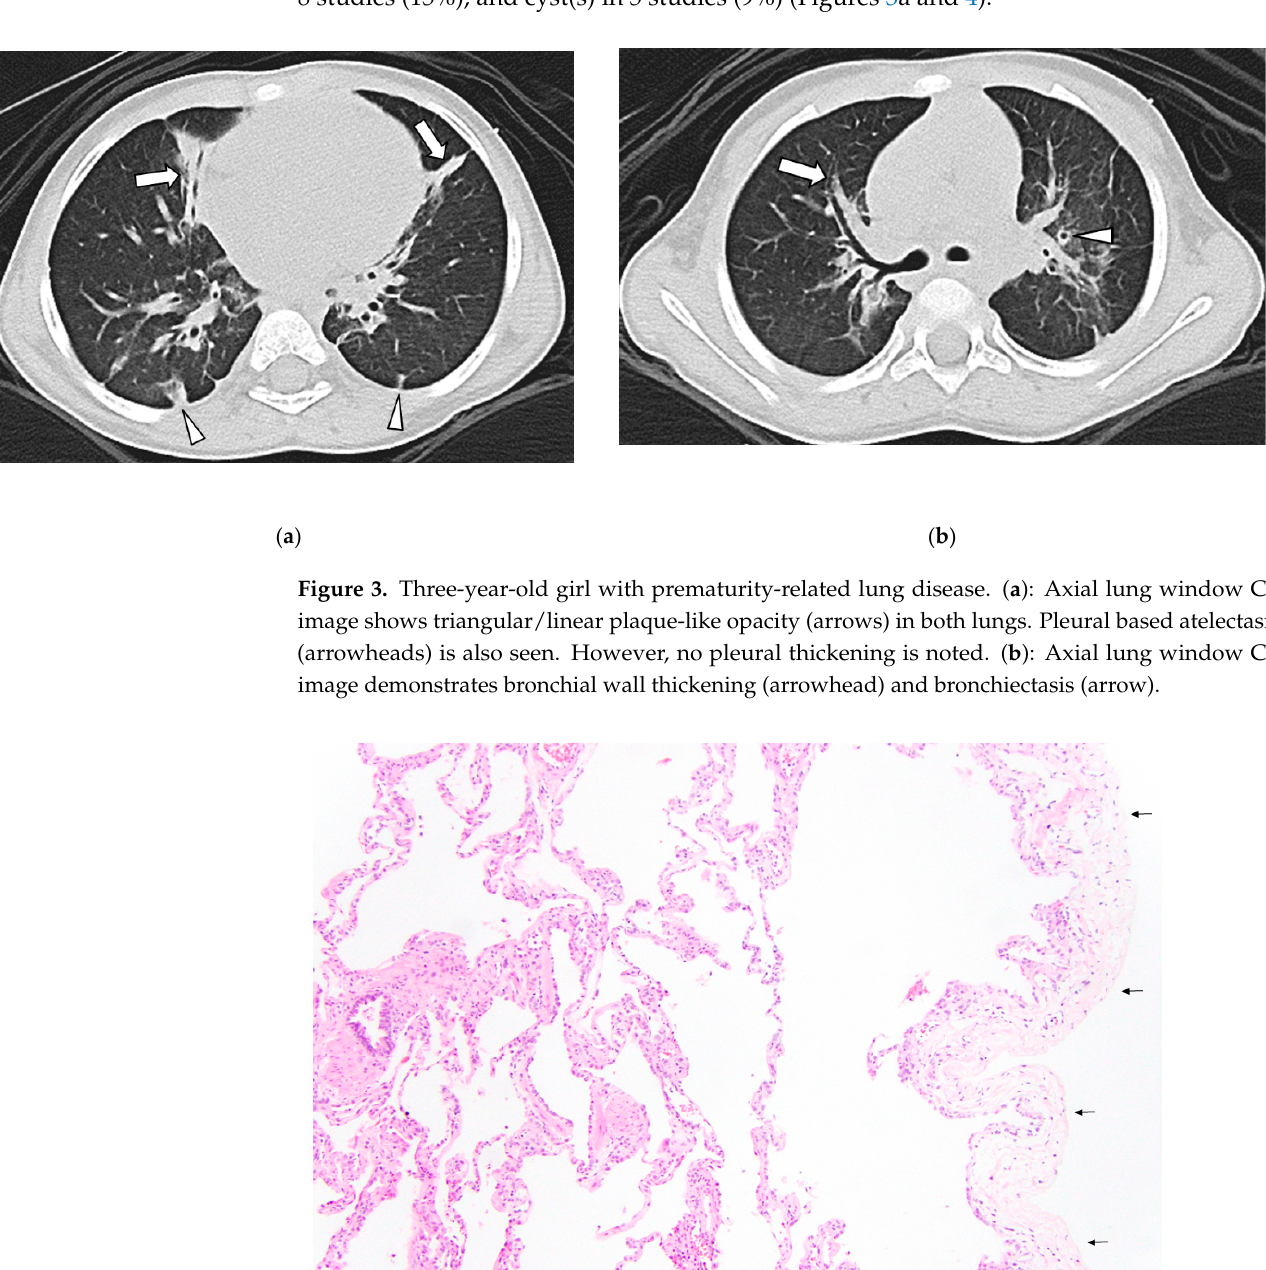
Figure 2. Histologic findings in pulmonary vein stenosis. After death at age 13 months, this pa- tient’s pulmonary veins showed fibrous intimal proliferation (left panel; hematoxylin and eosin; original magnification, 40×). The pleura (arrows) and interlobular septum were thickened, con- taining distended and tortuous veins (V) and thick-walled lymphatic channels (L) (right panel; hematoxylin and eosin; original magnification, 100×).